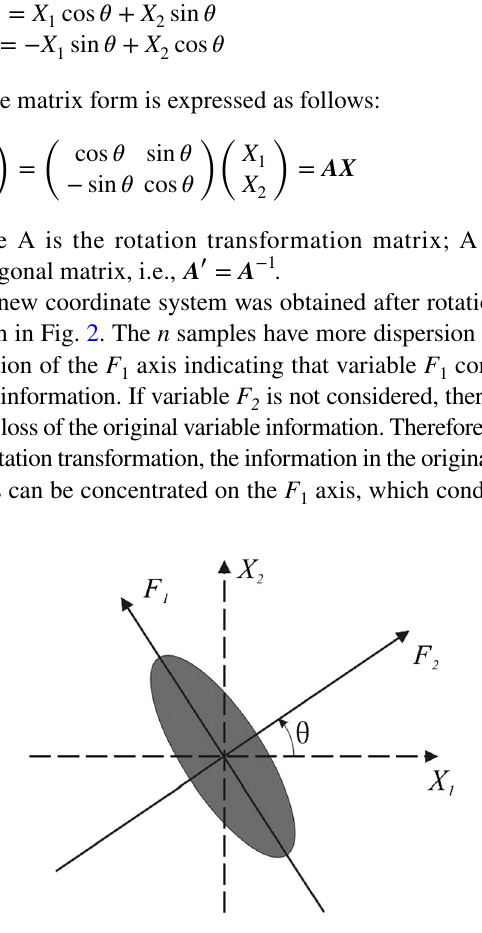
Fig. 2 Geometric interpretation of principal component